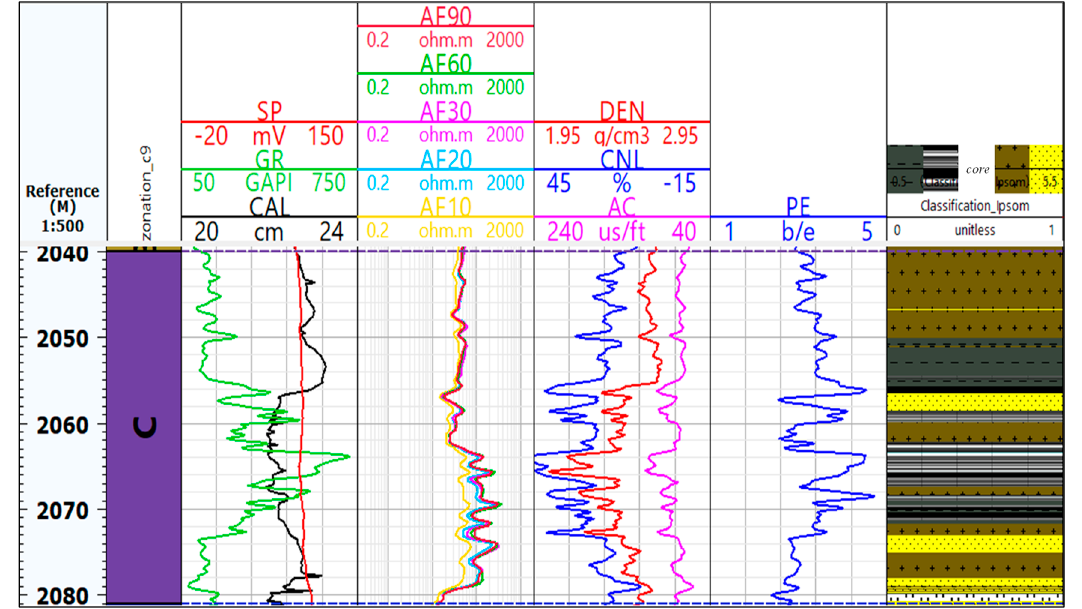
Figure 8. Flow chart of well logging lithology identification based on cluster analysis.